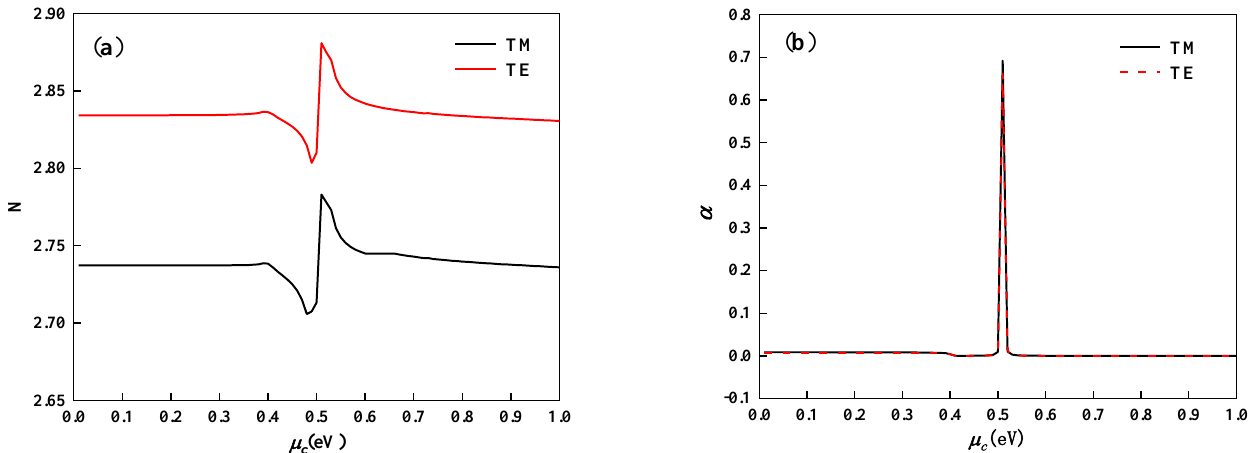
Figure 3. The mode field distribution in the waveguide. ( a ) The TM mode field distribution ( b ) The TE mode field distribution.